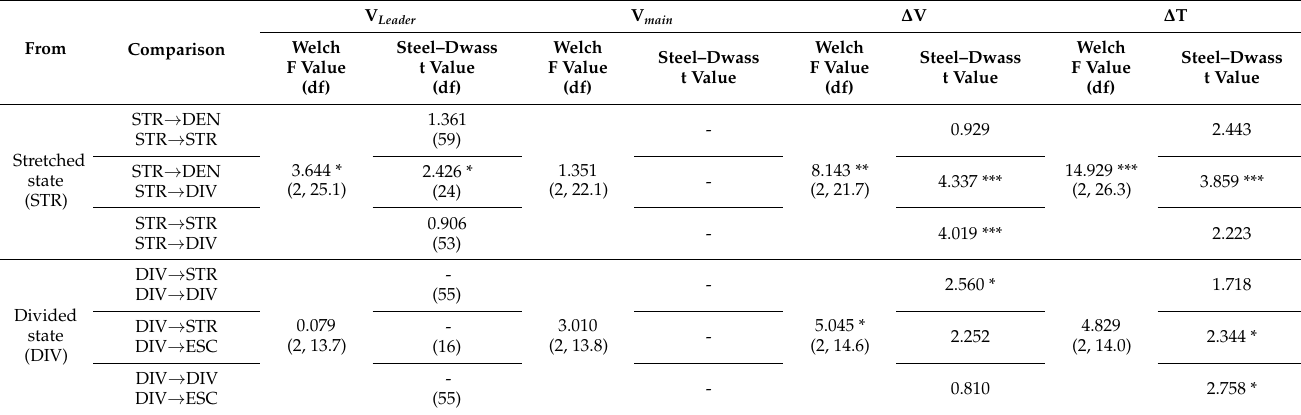
Figure 2. Separation and recombination. The box plots show candidate descriptive parameters V leader ( a , e ), V main ( b , f ), ΔV ( c , g ), and ΔT ( d , h ), respectively, when transitioning to each of the defined four states from STR or DIV. The distribution of the variables to each state from STR ( a – d ). The distribution of the variables to each state from DIV ( e – h ). Table 1. The results of ANOVA and multiple comparisons for V leader , V main , ΔV, and ΔT .